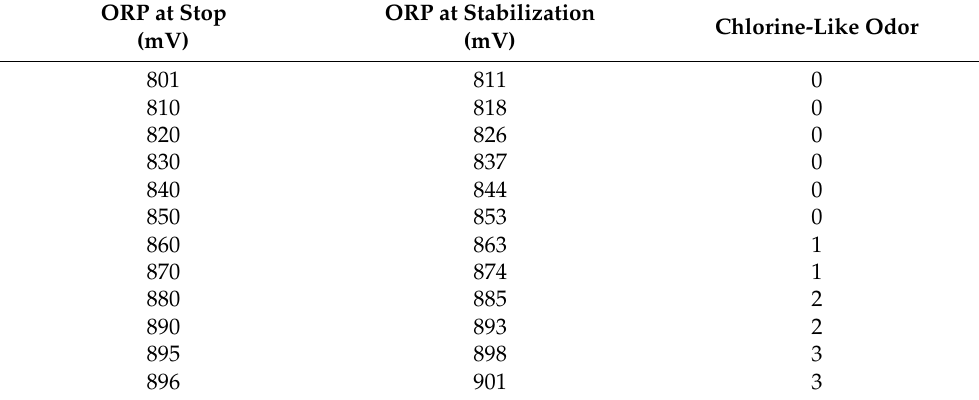
Table 1. Chlorine-like odor at 801–896 mV ORP of dosing stop in open